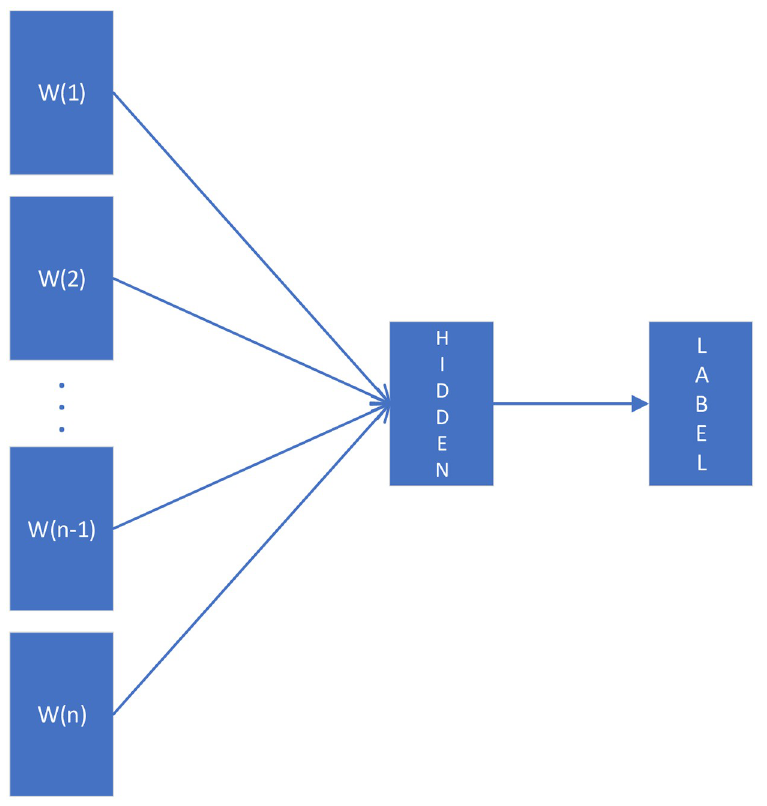
Fig 4. Model architecture of fastText classification